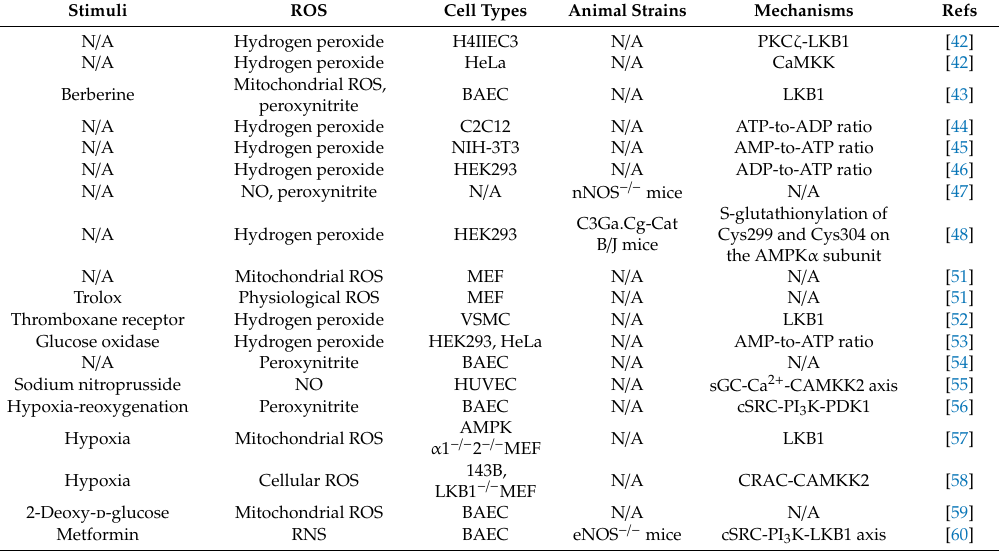
Table 1. The type of reactive oxygen species (ROS) that activates adenosine monophosphate-activated protein kinase (AMPK). ATP, adenosine triphosphate; ADP, adenosine diphosphate; BAEC, bovine aortic endothelial cell; MEF, mouse embryonic fibroblast; VSMC, vascular smooth muscle cell; HUVEC, human umbilical vein endothelial cell; NOS, nitric oxide synthase; LKB1, liver kinase B 1; CAMKK2, calcium / calmodulin-dependent protein kinase kinase; PDK1, pyruvate dehydrogenase kinase 1; CRAC, calcium release-activated